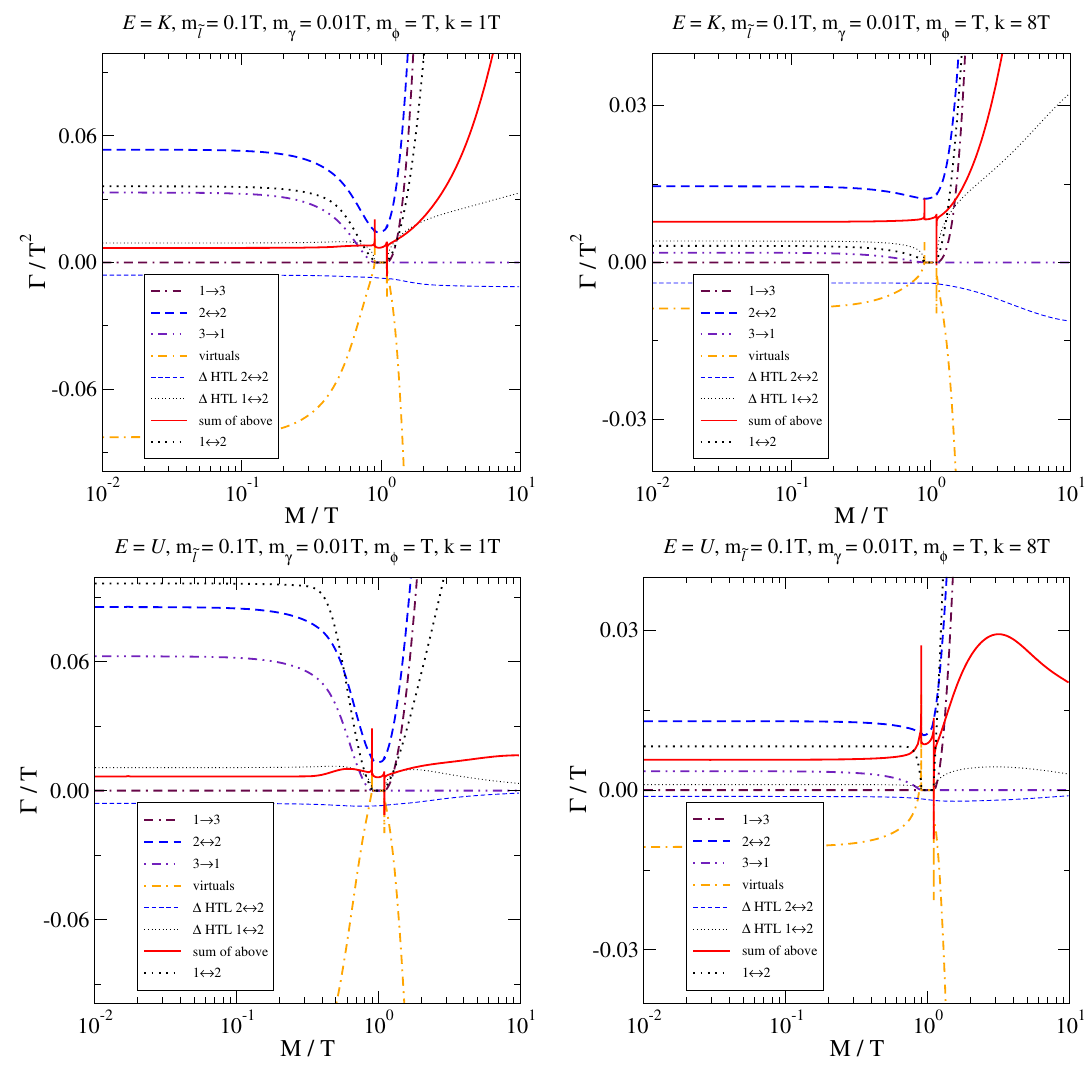
+ ∆Γ Born + ∆Γ HTL from eq. (7.1), as a function of M , for Figure 4 . Examples of Γ Born 2 ↔ 2 , 1 ↔ 3 1 ↔ 2 2 ↔ 2 , 1 ↔ 2 = m = 0 . 1 T , m = 0 . 01 T , m = m = T . The k = T (left) and k = 8 T (right). The masses are m γ ˜ ‘ ˜ φ ‘ φ spikes at around M = m result from an incomplete cancellation between the unresummed ± m ˜ ‘ φ Γ Born +∆Γ Born and the HTL subtraction-addition contribution ∆Γ HTL , as the latter 2 ↔ 2 , 1 ↔ 3 1 ↔ 2 2 ↔ 2 , 1 ↔ 2